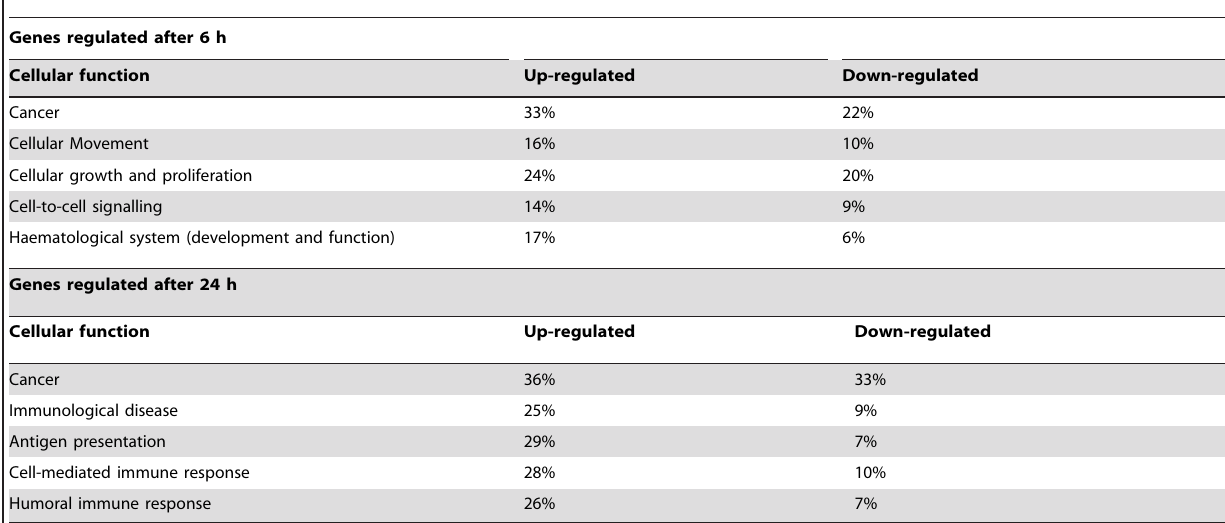
Table 1. Top five regulated gene categories according to cellular